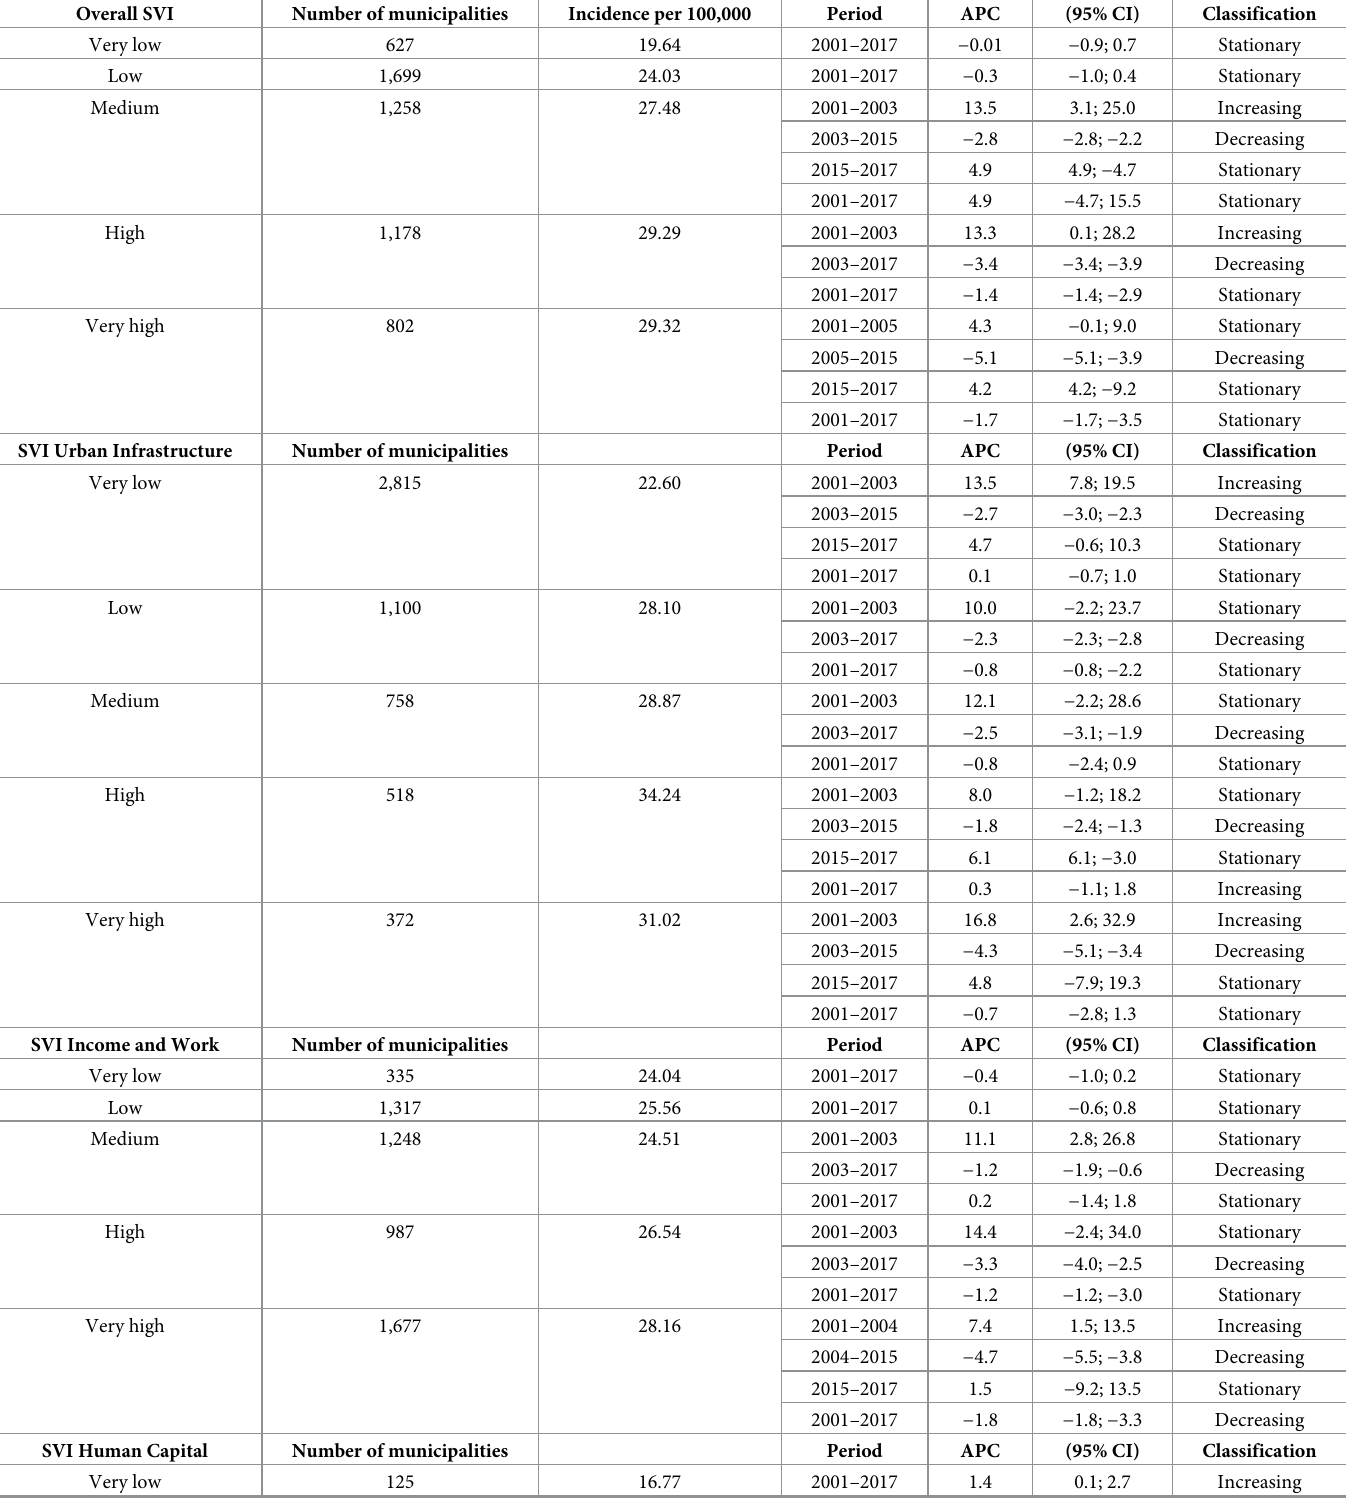
Table 4. Analysis of the incidence trend of tuberculosis per 100,000 inhabitants by Social Vulnerability Index classification. Brazil,